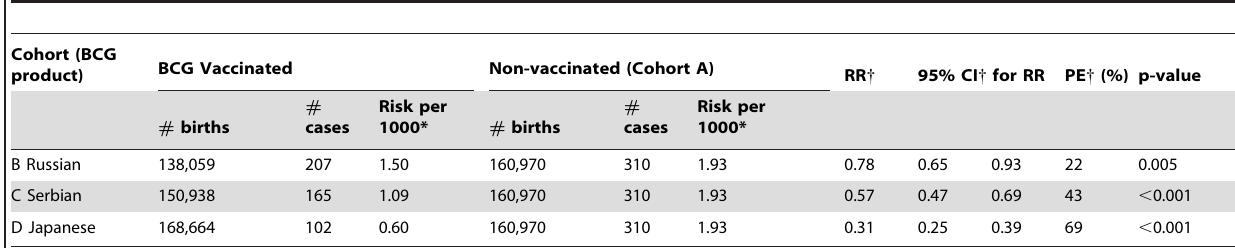
Table 2. BCG vaccine prevention effectiveness for clinically defined, radiologically confirmed TB cases, Kazakhstan, 2002–2008.